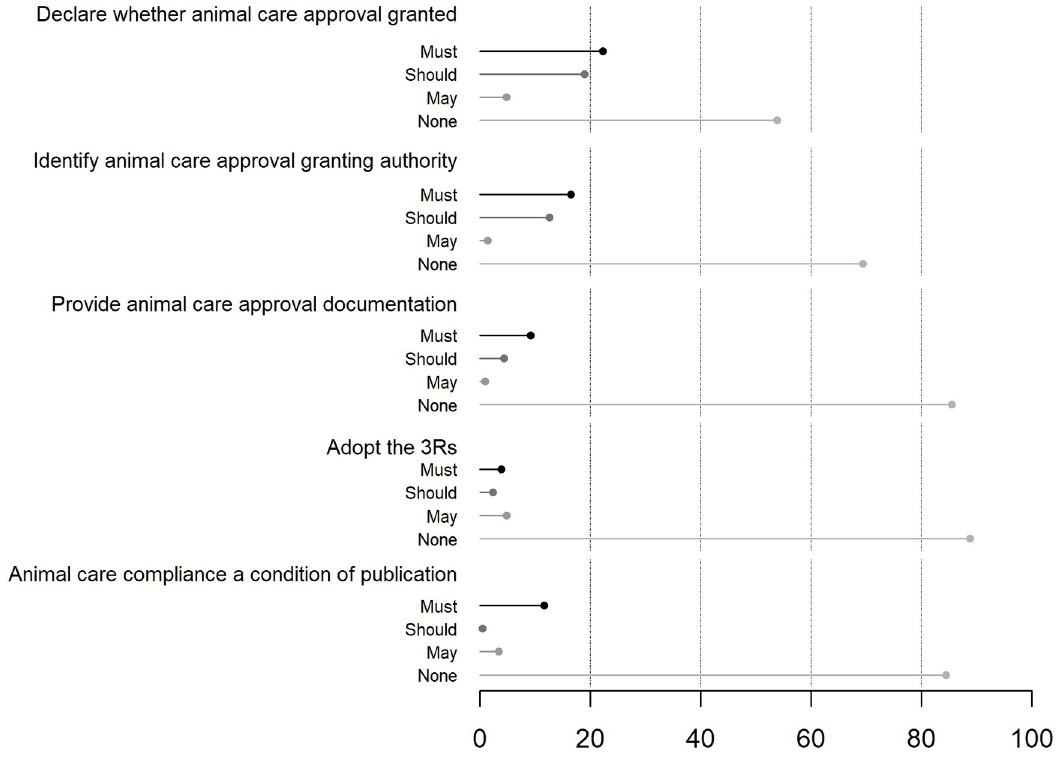
Fig 1. Presence and strength of compliance language in animal care policies across 206 journals that commonly publish wildlife research. 3R, replacement, reduction, refinement.